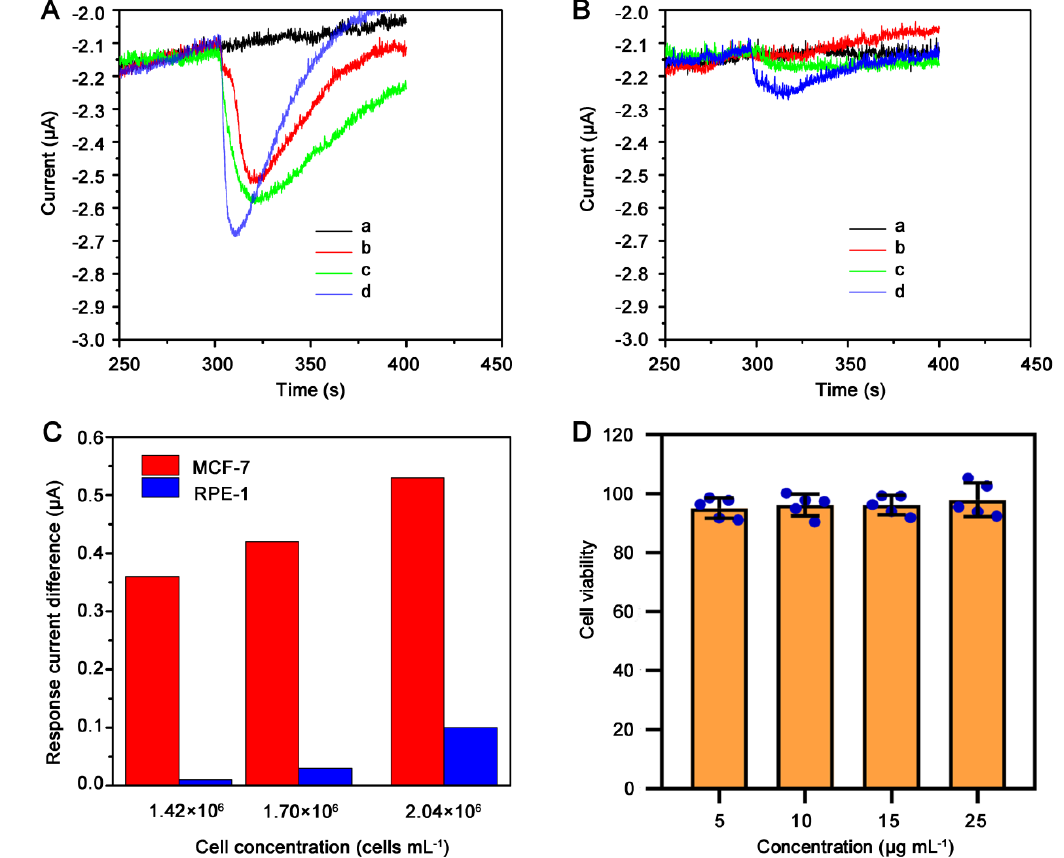
Figure 7. Detection of H 2 O 2 released from normal cells and living cancer cells. ( A ) Amperometric response of MoS 2 -Au-Ag / GCE to injection of 200 ng mL − 1 PMA with MCF-7 cells in 0.1 M PBS (pH 7.4). ( B ) Amperometric response of MoS 2 -Au-Ag / GCE to injection of 200 ng mL − 1 PMA with RPE-1 cells in 0.1 M PBS (pH 7.4). ( C ) Comparison of response current differences between MCF-7 and RPE-1 cells induced by H 2 O 2 release. ( D ) Effects of prepared MoS 2 -Au-Ag on metabolic activities of MCF-7 cells.